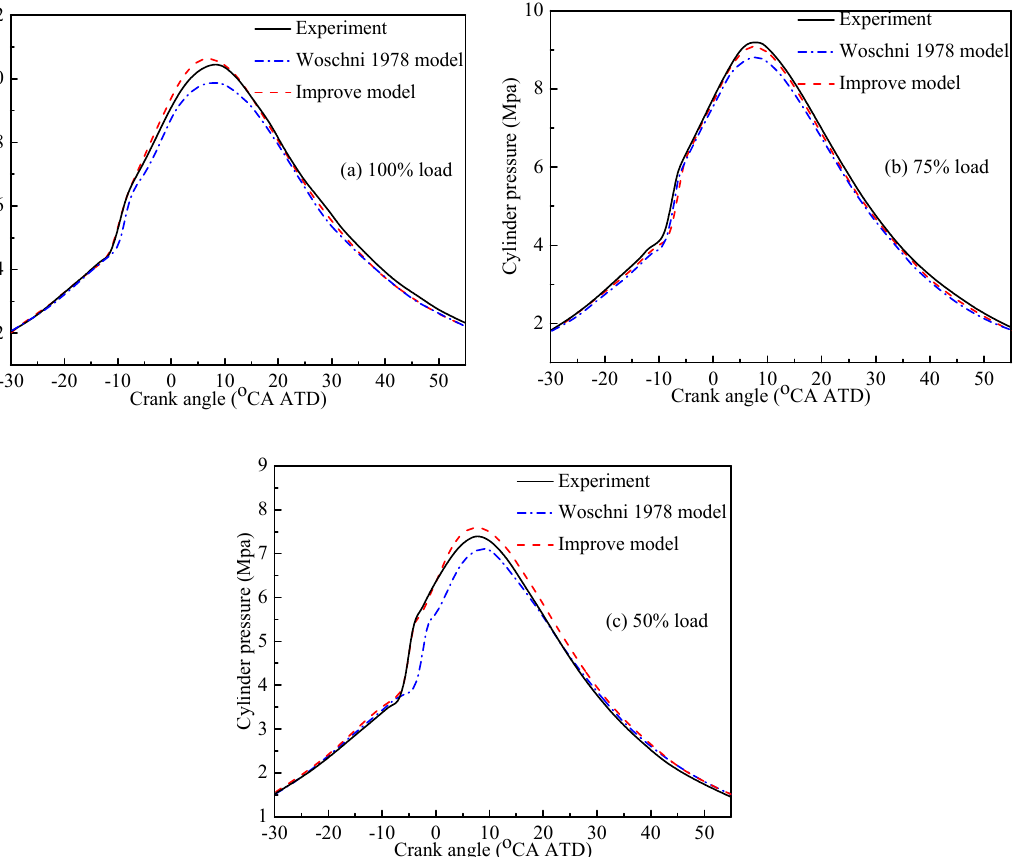
Figure 3. Comparison of cylinder pressure at 1000 rpm under different load conditions.